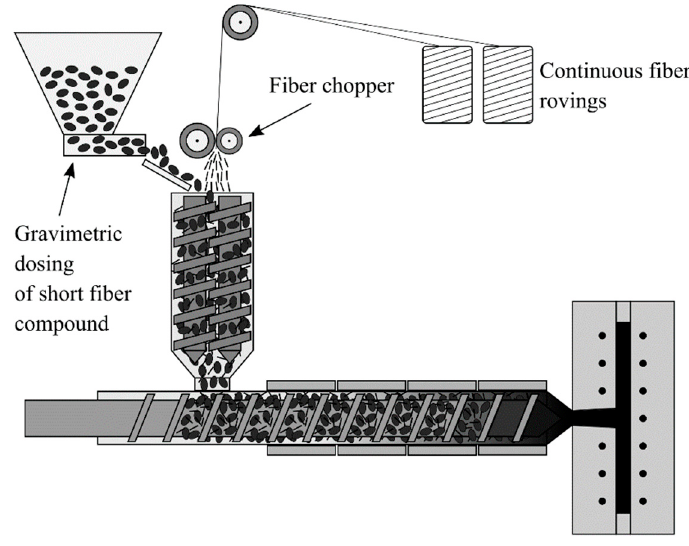
Figure 2. Process scheme of the long fiber thermoset injection molding process [57].